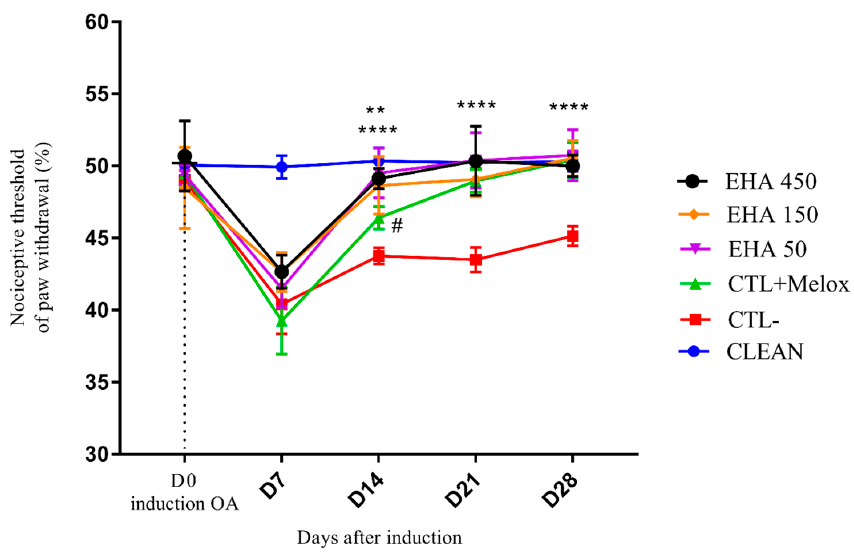
Figure 4. E ff ects of A. chica extract on mechanical hyperalgesia in rats with induced osteoarthritis (OA). The induction of OA was done by the injection of MIA (2 mg) in the knee of Wistar rats. After 3 days, the animals received oral saline (CTL − ), Meloxicam (CTL + Melox) and extract of A. chica at doses 50, 150, and 450 mg / kg (EHA50, EHA150, and EHA450). After 7, 14, 21, and 28 days of OA